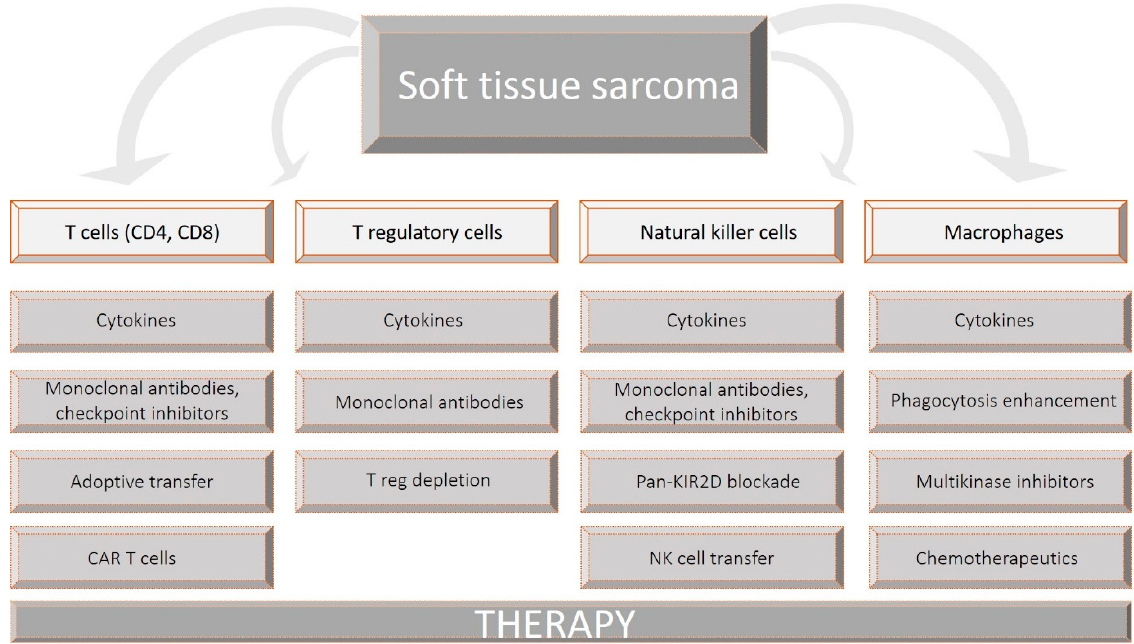
Figure 1. Scheme of the data selection process. Soft tissue sarcoma, T cells, CD3 T cells, CD8 T (cytotoxic) cells, CD4 T (helper) cells, natural killer (NK) cells, macrophages, T regulatory cells, Tregs, and FOXP3 T cells were used as the key words in the search strategy. Boxes below cell populations represent the search sub-categories. Therapies targeting the particular immune cell population were searched through the official registry at clinicaltrials.gov and search databases Medline/Pubmed, Scopus, and Web of Science. Articles published within the past ten years (Jan 1st 2011–July 1st 2021) were primarily taken into consideration.